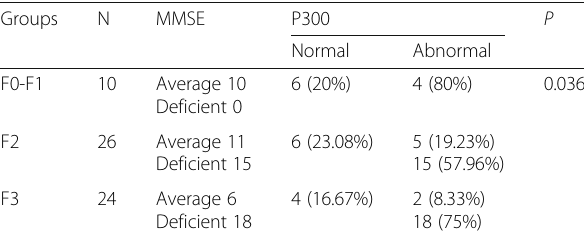
Table 7 Comparison of MMSE and peak latency of p300 percentage among the studied groups Groups